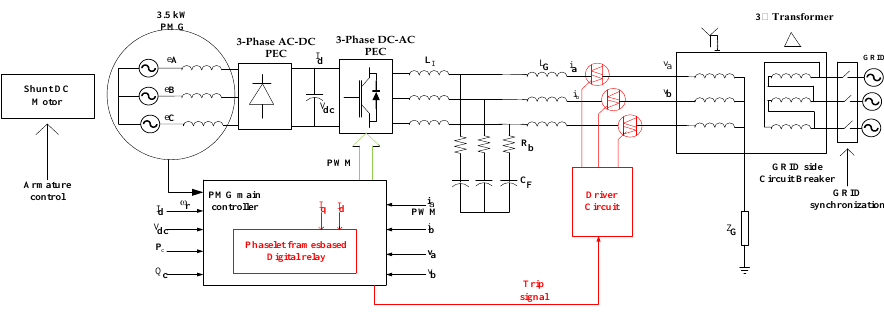
Figure 19. Experimental setup in schematic form for 3.5 -kW PMSG-based WECS.